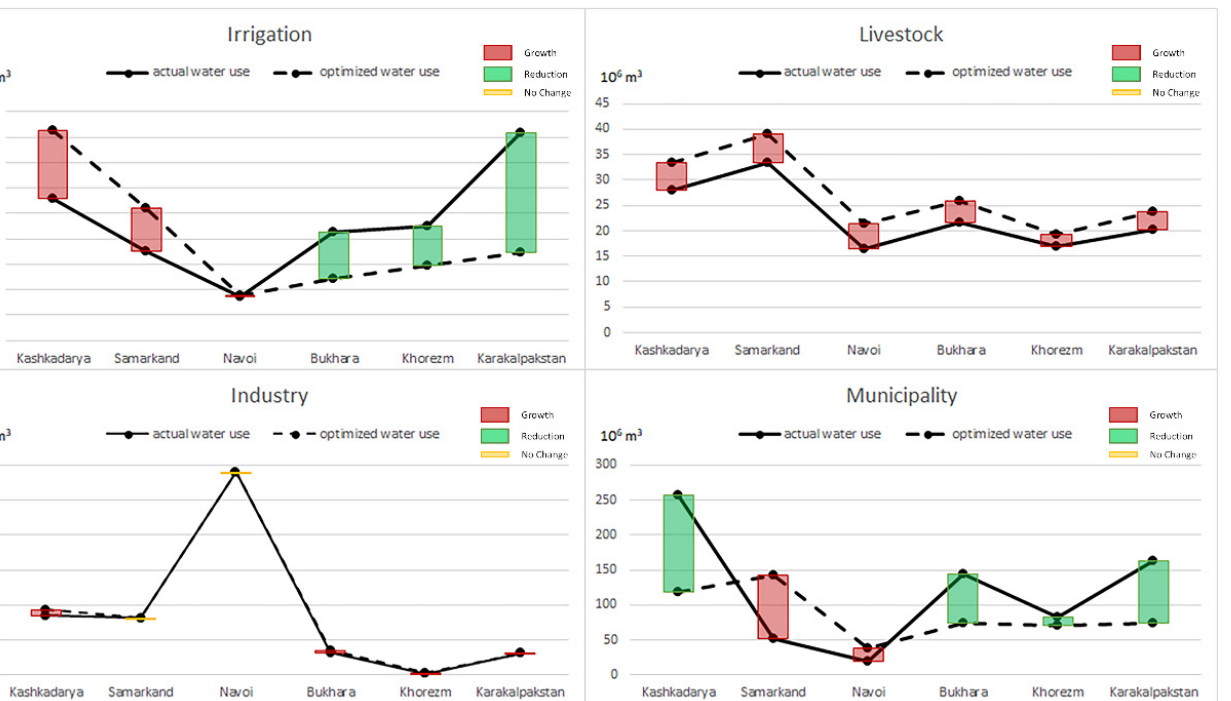
Table 14. Water allocation scheme in the sector of ecology.